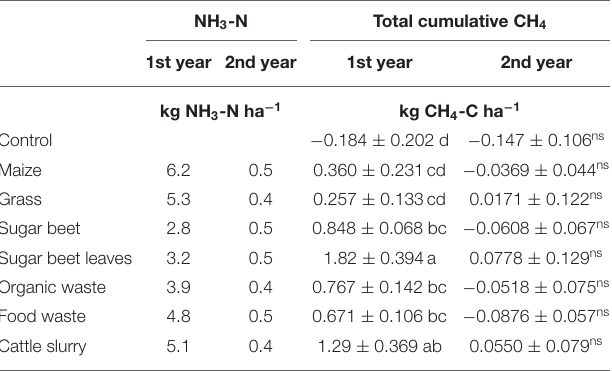
TABLE 6 | Modeled NH 3 -N losses over the first 72h after application (ALFAM2 model) and total cumulative CH 4 fluxes of digestates and unfertilized soil (control) after 55 (1st) and 58 days (2nd